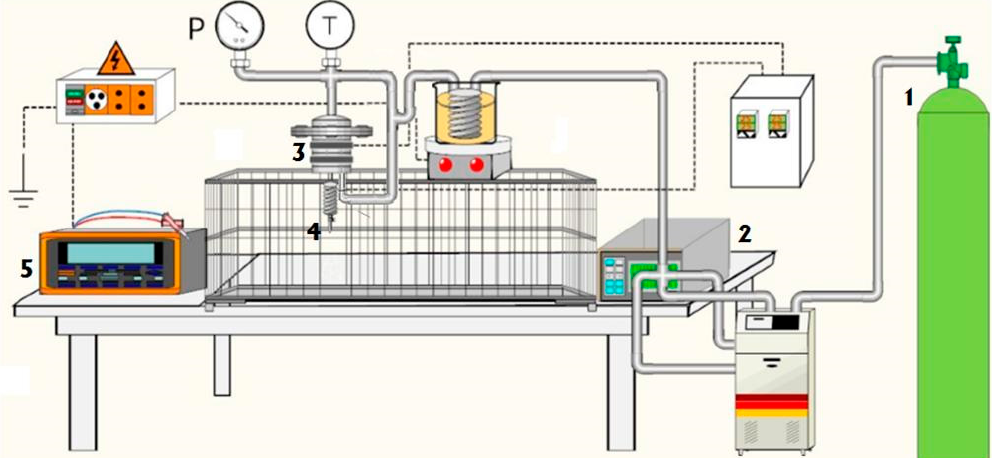
Figure 1. Schematic representation of the supercritical assisted electrospraying (SA-ESPR) plant: (1) CO 2 storage tank, (2) high-pressure pump, (3) high-pressure vessel, (4) nozzle and (5) generator. PVP particles were collected on an aluminum stub and sputter coated with gold (Agar Auto Sputter Coater mod. 108 A, Stansted, UK) at 30 mA for 80 s and analyzed by a field